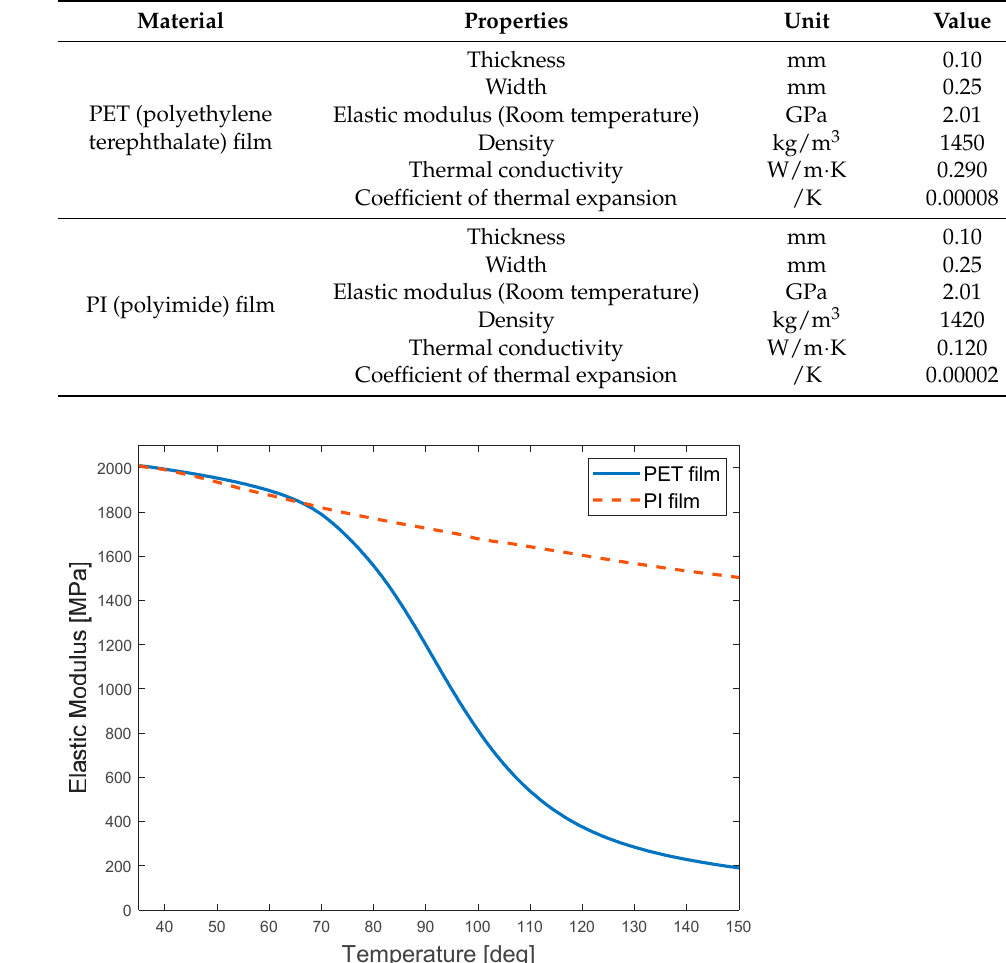
Table 1. Material properties of the PET and PI films.